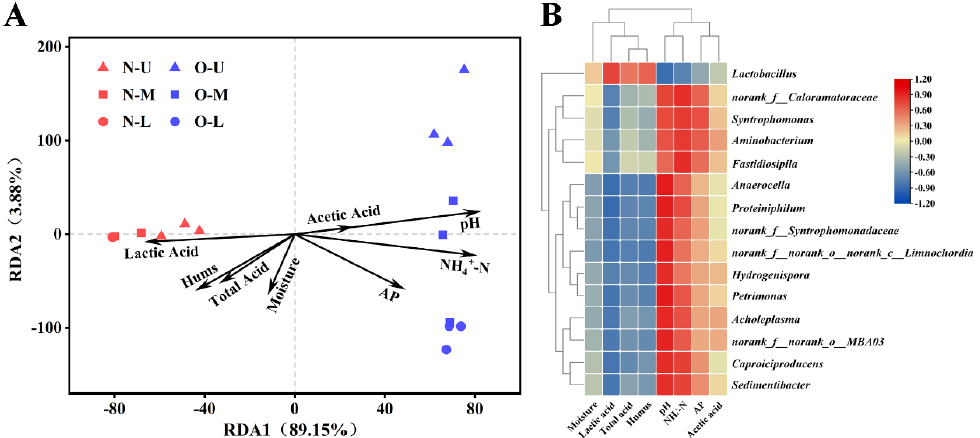
Figure 3. ( A ) Redundancy analysis revealed a correlation between the bacterial communities found in pit mud (PM) and the physicochemical properties of PM. N and O indicate new (3-year-old) and old (30-year-old) pit-well mud samples, respectively. U, M, and L indicate the upper, middle, and lower layers of PWM, respectively. ( B ) Heatmap constructed using Spearman correlation coefficients illustrates the correlations between physicochemical properties and the 15 bacterial genera